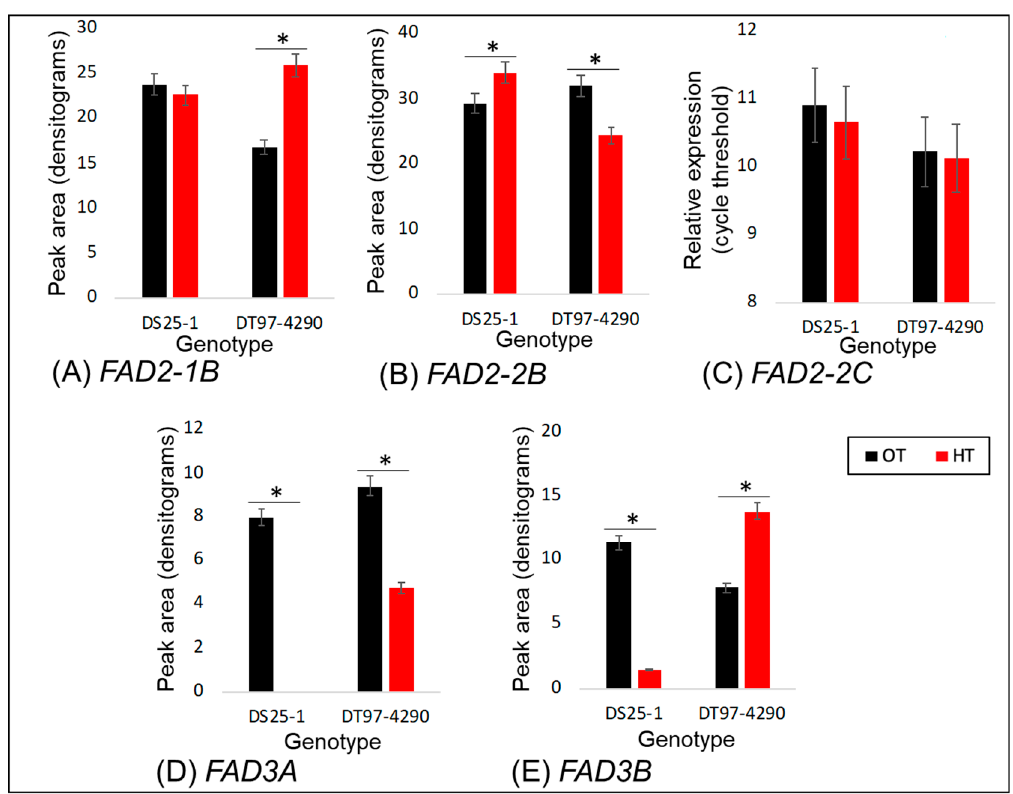
Figure 5. Changes in expression levels of the Fatty Acid Desaturase ( FAD ) genes under heat stress in the leaf samples (26 days old) of a heat-tolerant soybean genotype DS25-1 and heat-susceptible soybean genotype DT97-4290. DS25-1 showed significant reductions in expression levels of the FAD3A and FAD3B genes under heat stress conditions. RT-PCR was performed using gene-specific primers [24,25], and in all cases, gene expression results are normalized to the expression of the housekeeping gene ACTIN6 (see Supplementary Table S1). For this experiment, plants were grown under optimal temperature (OT; 30 / 20 ◦ C) or heat stress (HT; 38 ◦ C / 28 ◦ C) conditions. For RT-PCR analysis, three biological replicates were used, and for qRT-PCR analysis, three biological and two technical replicates were used. ( A & B ) semi-quantitative RT-PCR followed by electrophoresis and densitometric analysis. ( C ) qRT-PCR analysis. ( D & E ) semi-quantitative RT-PCR followed by digestion of PCR product with restriction endonuclease Van 91I, electrophoresis, and densitometric analysis [25,27]. The asterisk signifies a significant di ff erence in the expression level of the FAD genes in two soybean genotypes under two treatments. The Student’s t -test was used to compare the expression level of the FAD genes under two treatments. The error bars signify the standard